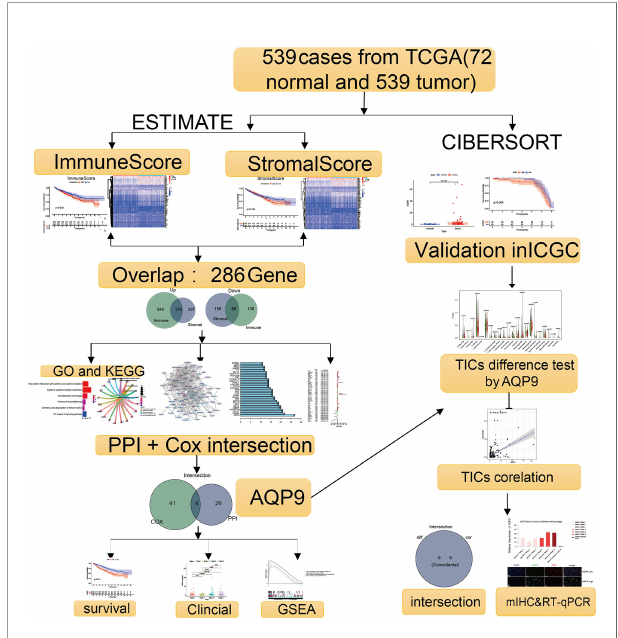
FIGURE 1 | Flowchart of the